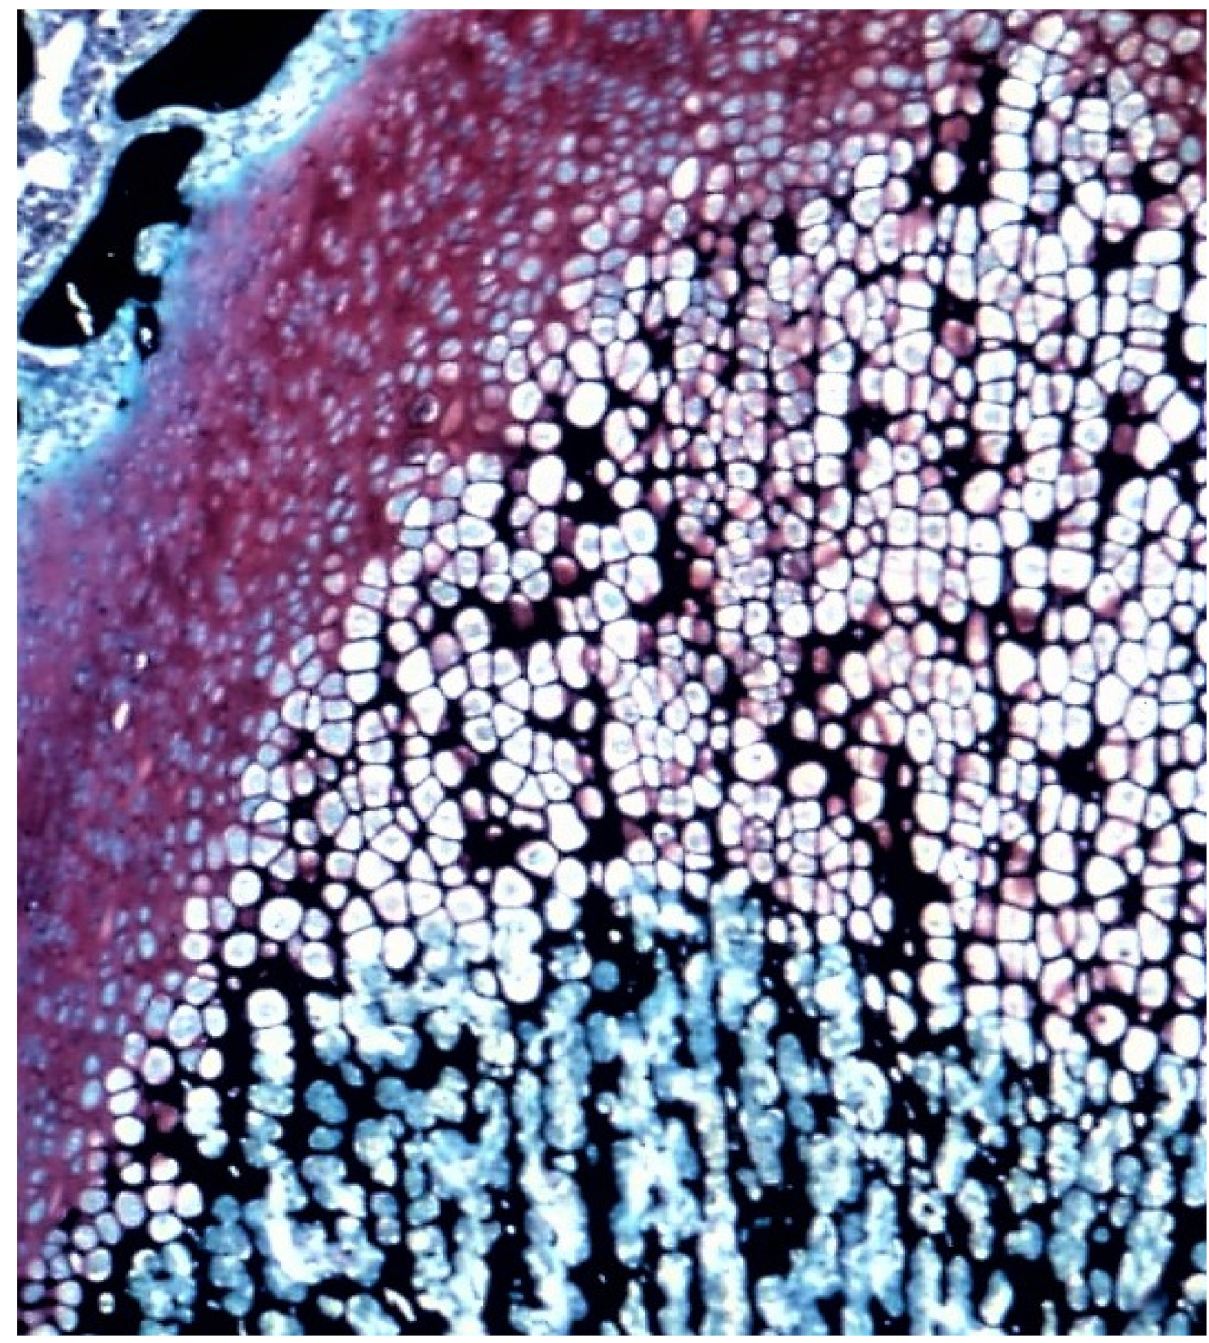
Figure 4. Rat growth plate stained with Safranin O, hematoxylin and eosin, and silver nitrate. The growth plate provides an example of physiological endochondral bone formation. The cartilage pre- cursor (pink Safranin O stain) undergoes calcification (black) and then ingrowth of microvasculature, which produces chondroclasis and replacement by osteoblasts and woven bone (black and blue) (40 × ). Adapted with permission from Ref. [5]. 1988, Calcified Tissue International